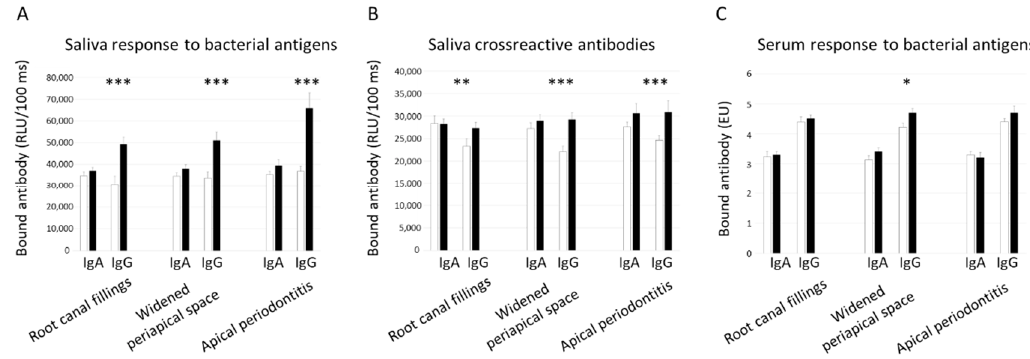
Figure 1. Saliva and serum antibody levels according to endodontic findings. The patients were divided into groups according to the presence of root canal fillings, widened periapical spaces, and apical periodontitis. Saliva (A, B) and serum (C) IgA- and IgG-class antibodies were determined. The bacterial antigens included A. actinomycetemcomitans , P. gingivalis , P. intermedia , P. endodontalis , and T. forsythia . The antigens giving rise to cross-reactive antibodies included MAA-LDL, Rgp-44, and Aa-HSP60. White columns depict the absence of the endodontic finding and black columns depict the presence of the endodontic finding. Means and standard errors are shown. The asterisks depict statistical significance between the groups defined by the t -test after logarithmic transformation: * p < 0.05, ** p < 0.01. *** p < 0.001.